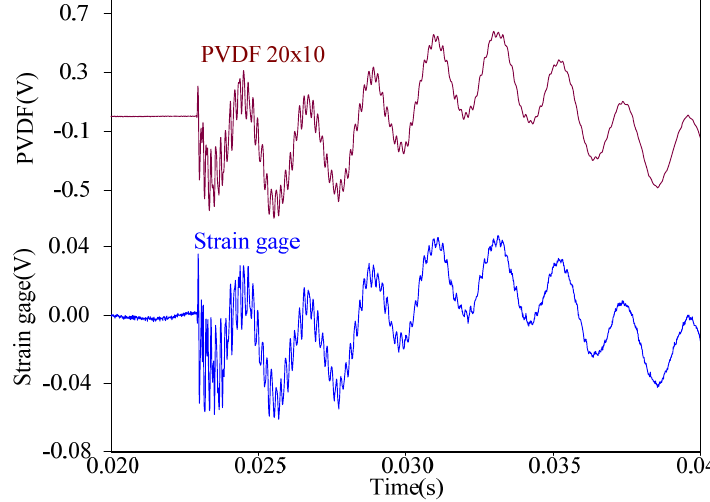
Figure 17. Measurement results of PVDF 20 × 10 and the strain guage with impact on location